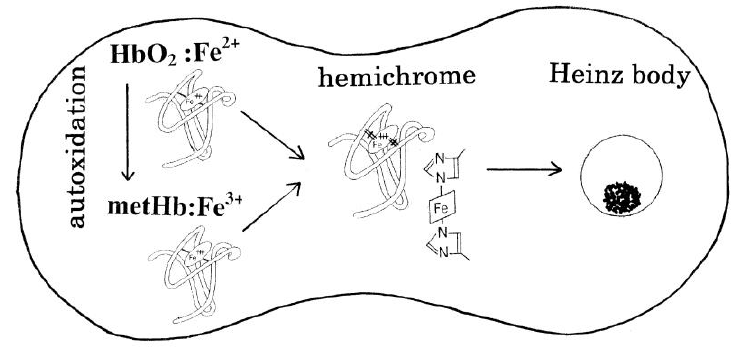
Figure 10. Diagram representing biosensing mechanisms in the spleen responsible for the removal of aged and damaged red cells from the blood